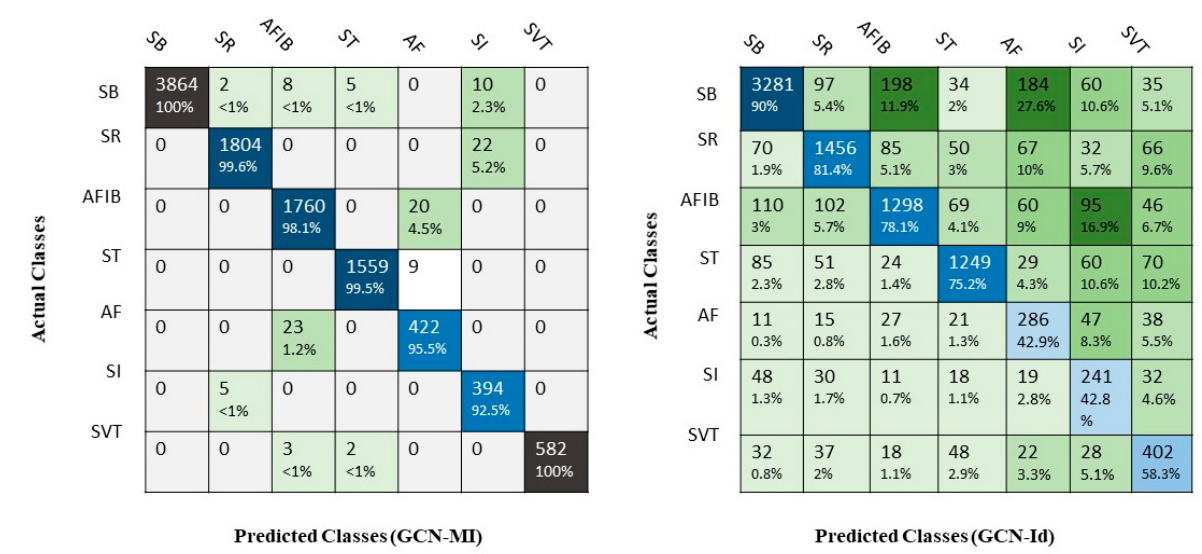
Figure 7. Confusion matrix for all records using GCN-MI and GCN-Id.